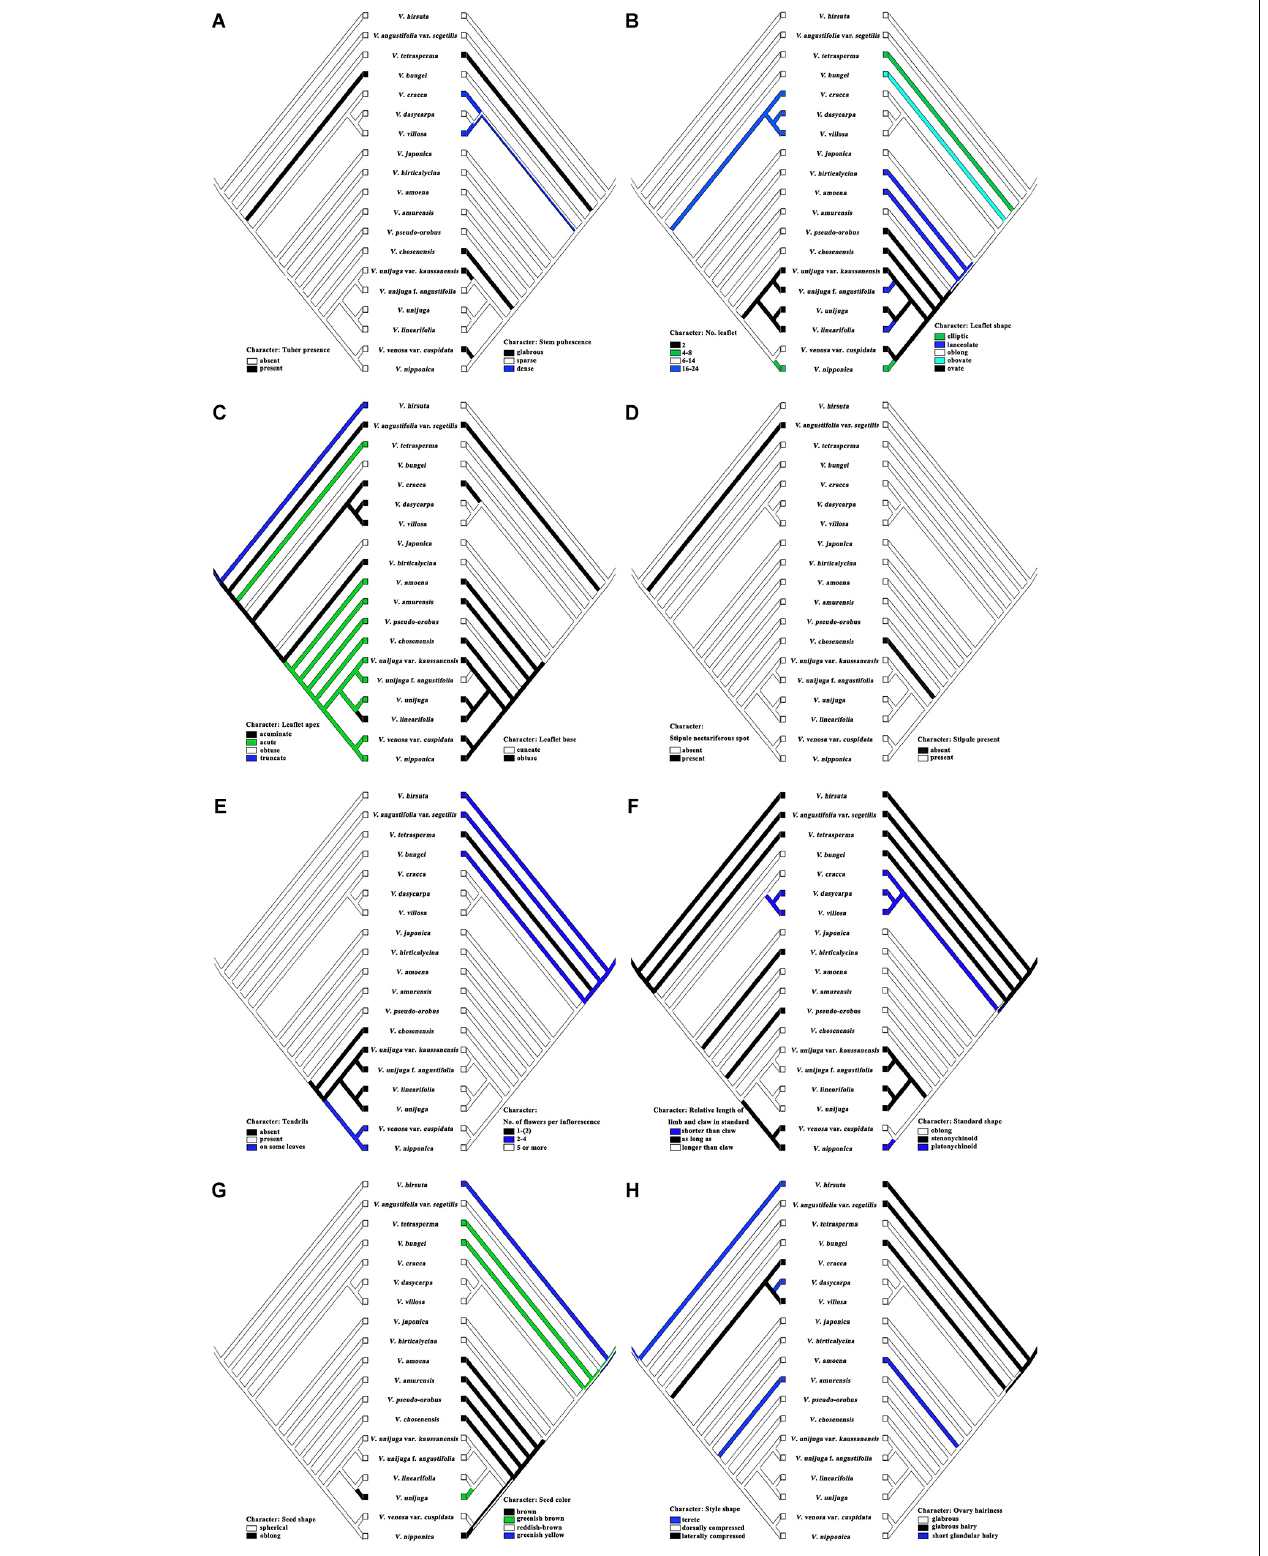
FIGURE 5 | Character state mapping of 16 useful morphological characteristics. (A) Character of Tuber presence and Stem pubescence; (B) Character of No. of leaflets and Leaflet shape; (C) Character of Leaflet apex and Leaflet base; (D) Character of Stipule nectariferous spot and Stipule present; (E) Character of Tendrils and No. of flowers per inflorescence; (F) Character of relative length of limb and claw in standard and Standard shape; (G) Character of Seed shape and Seed color; (H) Character of Style shape and Ovary hairiness. Frontiers in Plant Science |